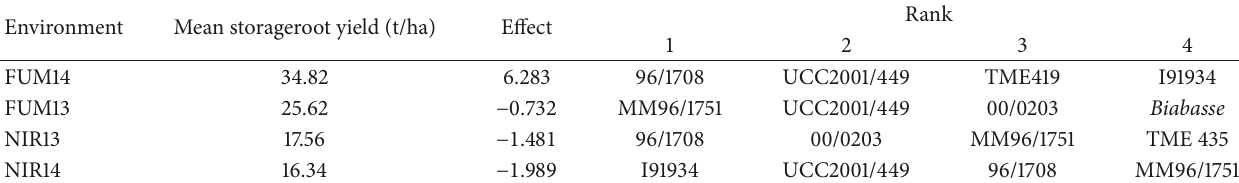
Table 8: First four AMMI selections based on best root yielding genotype in each environment.